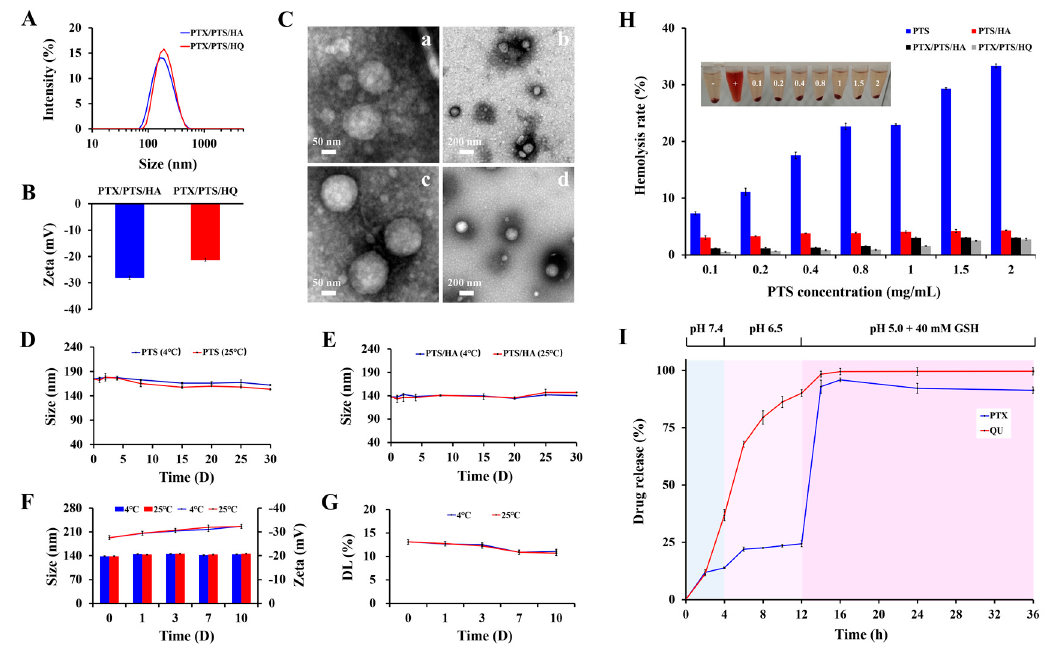
Figure 3. Characterization and pharmaceutical evaluation of PTX/PTS/HQ PNPs. ( A ) Hydrody- namic size distribution and ( B ) zeta potential of PTX/PTS/HA PNPs and PTX/PTS/HQ PNPs. ( C ) Typical TEM images of ( a,b ) PTX/PTS/HA PNPs and ( c,d ) PTX/PTS/HQ PNPs at different bars. Size changes of ( D ) PTS blank PNPs and ( E ) PTS/HA blank PNPs at 4 °C and 25 °C for 30 days. Storage stability of PTX/PTS/HQ PNPs, including ( F ) particle size (line chart), zeta potential (column chart), and ( G ) DL (%) of PTX at 4 °C and 25 °C for 10 days. ( H ) Hemolysis assay of PTS blank PNPs, PTS/HA blank PNPs, PTX/PTS/HA PNPs, and PTX/PTS/HQ PNPs with PTS concentrations in the range of 0.1–2 mg/mL. The inset image represents the hemolysis situation of PTX/PTS/HQ PNPs. ( I ) Dual pH/redox-responsive release profile of QU and PTX from PTX/PTS/HQ PNPs with or without 40 mM GSH at pH 7.4, pH 6.5, and pH 5.0 for 36 h, respectively. Data are presented as the mean values ± SD ( n = 3).